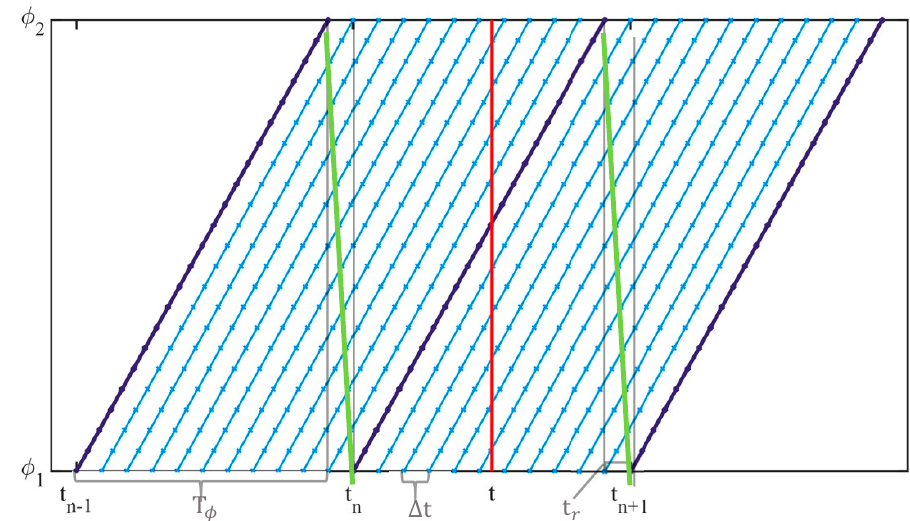
Figure 5. Temporal alignment of a PPI scan at time t . Dark-blue lines indicate LiDAR measurements, light-blue lines indicate the propagation steps, green lines indicate the measurement reset time ( t r ), and the red line marks the time of interpolation. This example shows N φ = 11 .